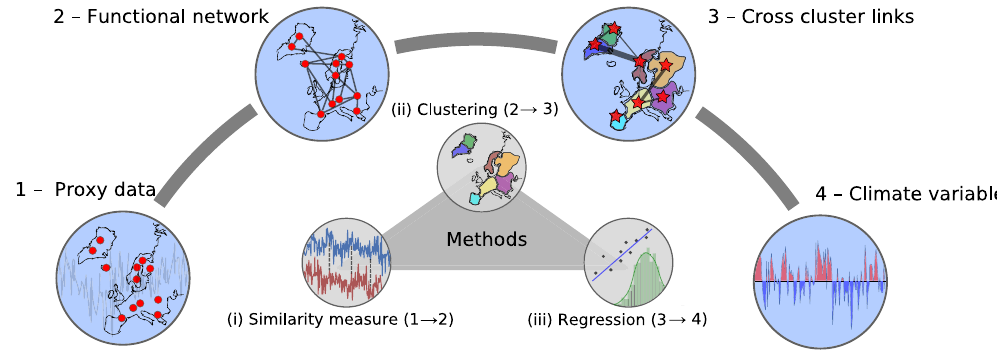
Figure 2. Schematic overview on the methodological approach of this study. Based upon a network of paleoclimate proxy records, we construct evolving functional networks encoding the co-variability among the different time series. Using cluster analysis, we simplify the emerging network structures and obtain quantitative measures of the inter-cluster linkages as key characteristics of the obtained networks. These variables are then related to an established long-term reconstruction of the NAO index via linear